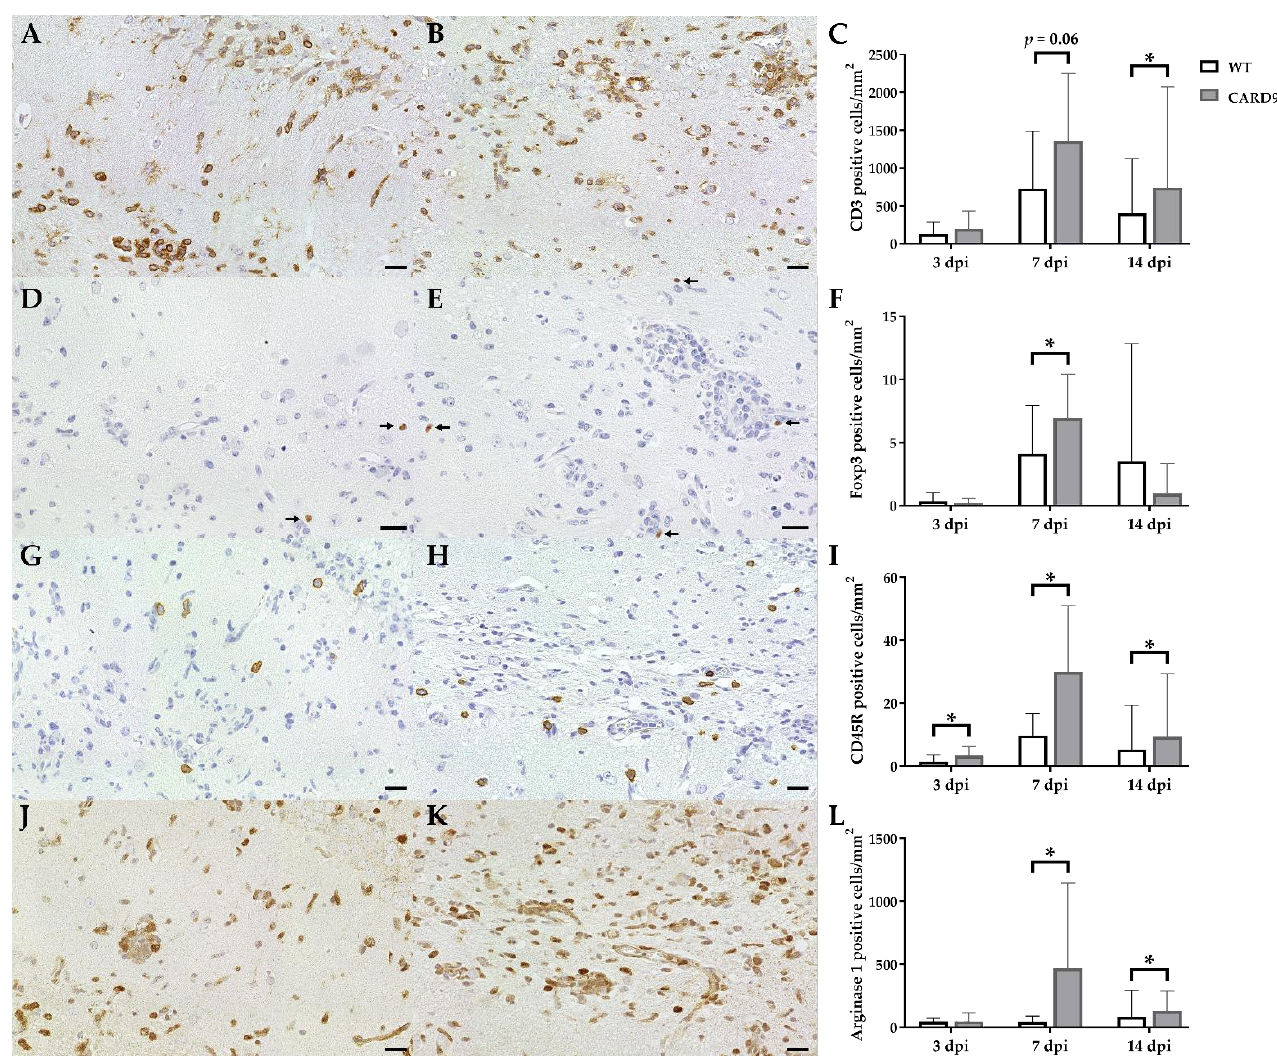
Figure 3. Phenotyping of immune cells in the hippocampus of C57BL/6 wild-type (WT) mice and CARD9 −/− mice following Theiler’s murine encephalomyelitis virus (TMEV) infection. CD3-specific immunostaining in the hippocampus of ( A ) a WT mouse and ( B ) a CARD9 −/− mouse at 7 days post infection (dpi), which shows a prominent infiltration of CD3 + T cells (arrows) in CARD9 −/− mice. ( C ) Quantification of CD3 + T cells in the hippocampus. ( D ) Image of few Foxp3 + regulatory T cells (arrow) in a WT mouse at 7 dpi. ( E ) Increased numbers of Foxp3 + cells (arrows) in a CARD9 −/− mouse at 7 dpi. ( F ) Quantification of Foxp3 + regulatory T cells in the hippocampus. ( G ) Low numbers of CD45R + B cells in a WT mouse at 7 dpi. ( H ) Increase in CD45R + B cells in the hippocampus of a CARD9 −/− mice at 7 dpi. ( I ) Quantification of CD45R + B cells in the hippocampus. ( J ) Image of arginase 1 + M2-type macrophages/microglia in the hippocampus of a WT mouse at 7 dpi. ( K ) Increase in arginase 1 + M2-type macrophages/microglia in a CARD9 −/− mice at 7 dpi. ( L ) Quantification of arginase 1 + cells in the hippocampus. * Significant difference between WT and CARD9 −/− mice ( p ≤ 0.05; Mann–Whitney U -test). Three dpi: WT n = 10, CARD9 −/− n = 10; 7 dpi: WT n = 10, CARD9 −/− n = 9; 14 dpi: WT n = 10, CARD9 −/− n = 10. Data are displayed as mean with SD. Immunohistochemistry, scale bar: 20 µm ( A , B , D , E , G , H , J , K ).